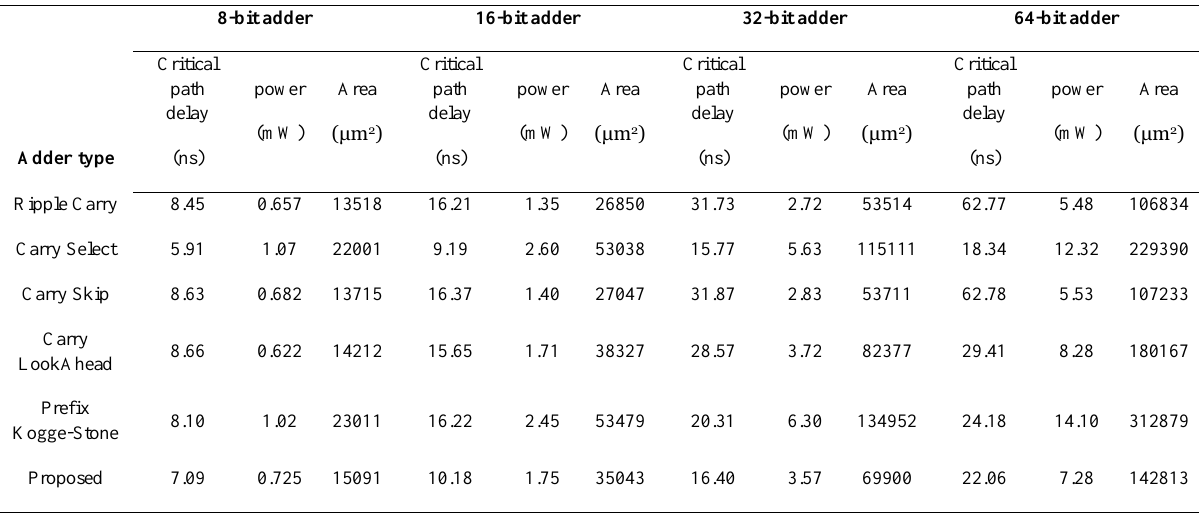
Table 4. Comparison of the proposed fast adder with other fast adders in terms of delay, area, and power consumption in a low speed with t = 125°C and V supply = 1.62 v.